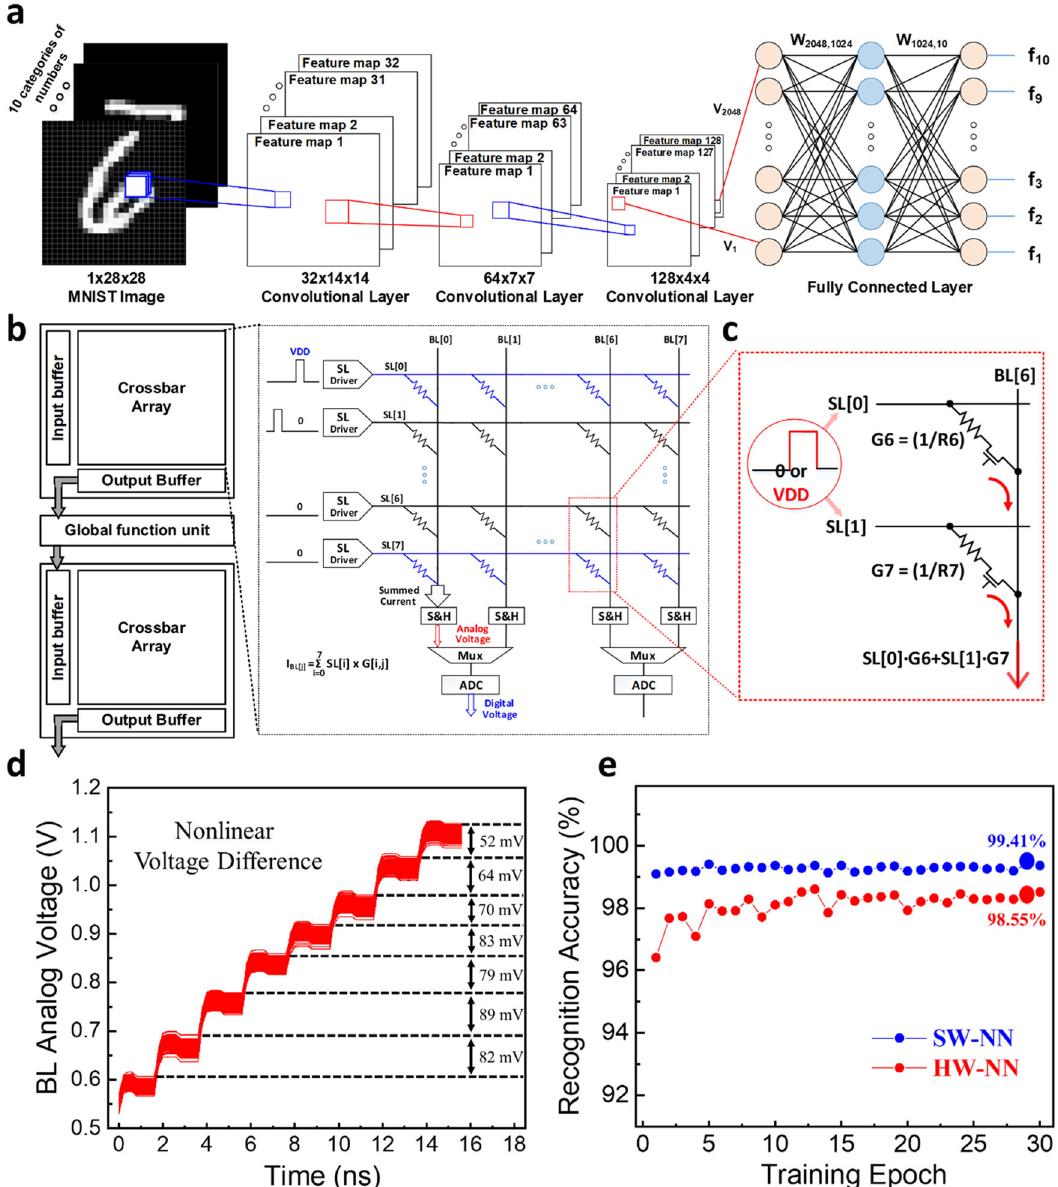
Fig. 4 Accuracy evaluation of the proposed MoS 2 memristor. a Structure of convolutional neural network model simulated for MNIST dataset accuracy evaluation. b Overall architecture of 8 × 8 crossbar array including peripheral circuit. c Explanation of MAC operation which is performed in a crossbar array. d 1000 times Monte-Carlo simulation result in 8 by 8 crossbar array with the memristor device variation considered as 3 σ 5%. e Recognition accuracy graph of SW-NN and HW-NN for each training epoch. The top accuracy of SW-NN and HW-NN is 99.41% and 98.55%,